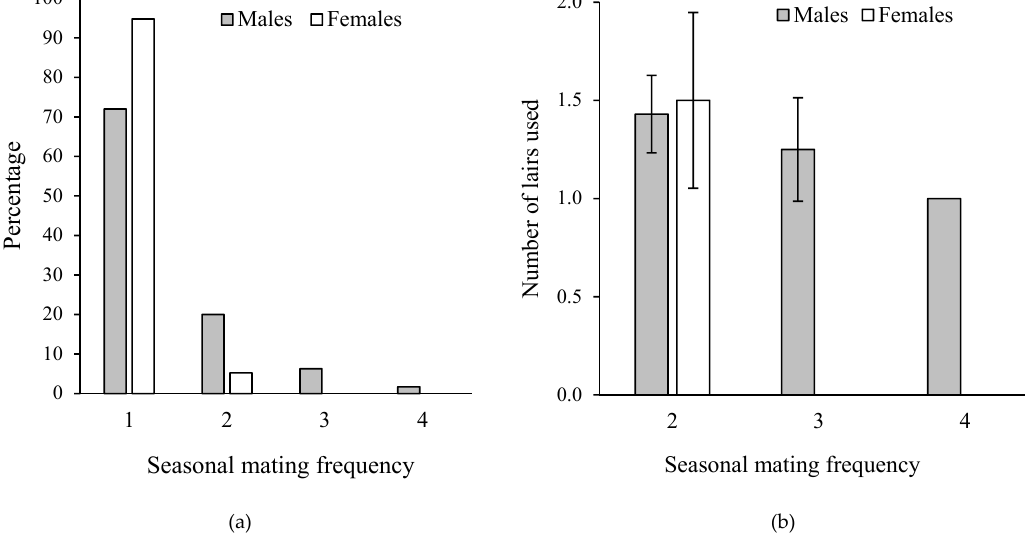
Figure 4. ( a ) Seasonal mating frequency (Dec–May) for males and females for all sites combined. 28% of males spawned more than once, 5% of females spawned more than once. ( b ) Mean ± SE number of spawning lairs used as a function of seasonal mating frequency. Males often reused the same site for sequential broods. Data from [11].